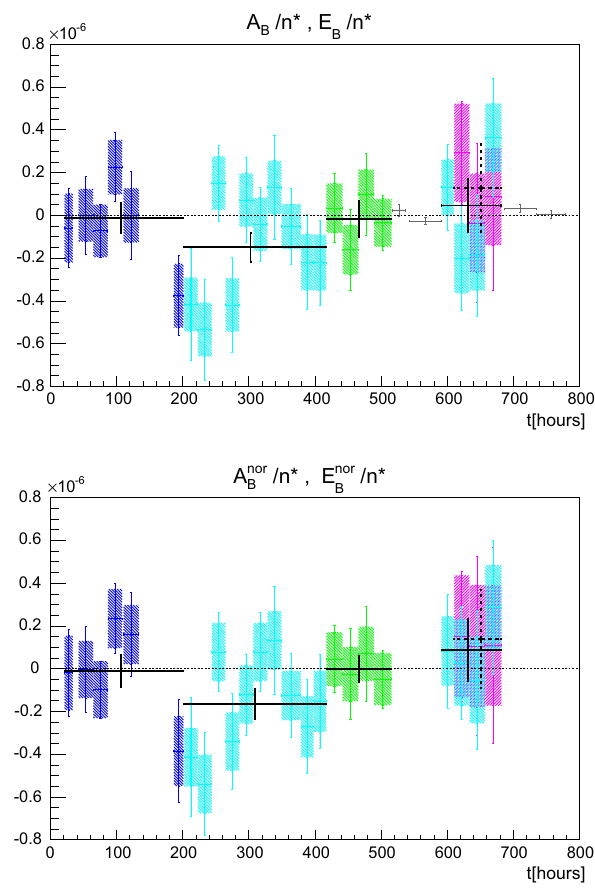
Fig. 5 Binned results for D B (upper panel) and D nor B (lower panel) from the data acquired in configurations B 1 ( B c = 0 . 21G, blue), B 2 ( B c = 0 . 12G, cyan), B 3 ( B c = 0 . 09G, green) and B 4 ( B c = 0 . 12G, again cyan). Shaded squares correspond to expected statistical errors, while the data dispersion in bins are indicated by longer error bars. Magenta squares and error bars indicate the results for (cid:14) B and (cid:14) nor B from { 0 | B } -mode measurements of series B 4. Grey crosses in upper panel correspond to calibration series